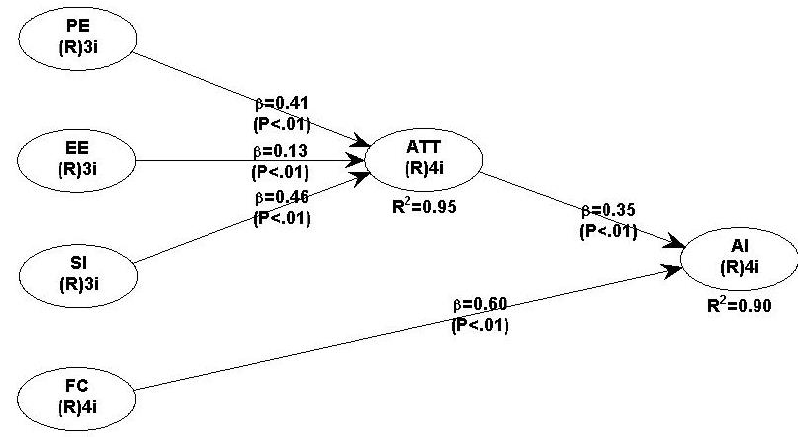
Figure 1: Validated Research Model